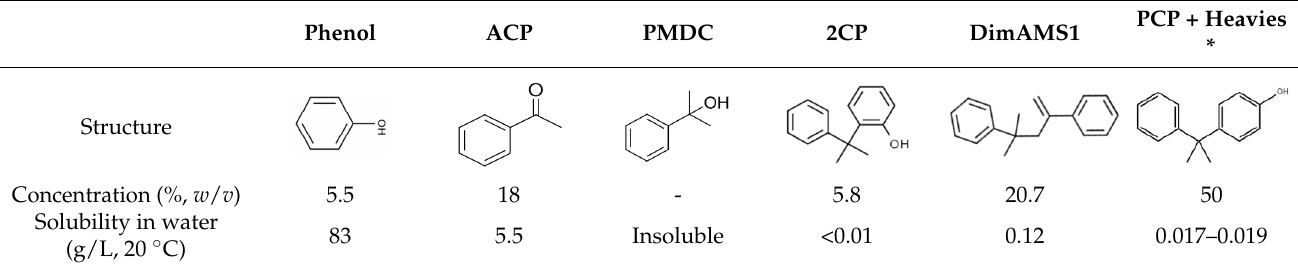
Table 1. Chemical composition of PS used for biodegradation experiments. Concentration data are expressed in percent- age (%, w / v ) of each component in the PS. ACP: acetophenone; PMDC: 2-phenyl-2-propanol; 2CP: o-cumylphenol; DimAMS1: 1,1´-(1,3,3-trimethylprop-1-ene-1,3-diyl)dibenzene; PCP: 4-cumylphenol and BPA: BisphenolA.